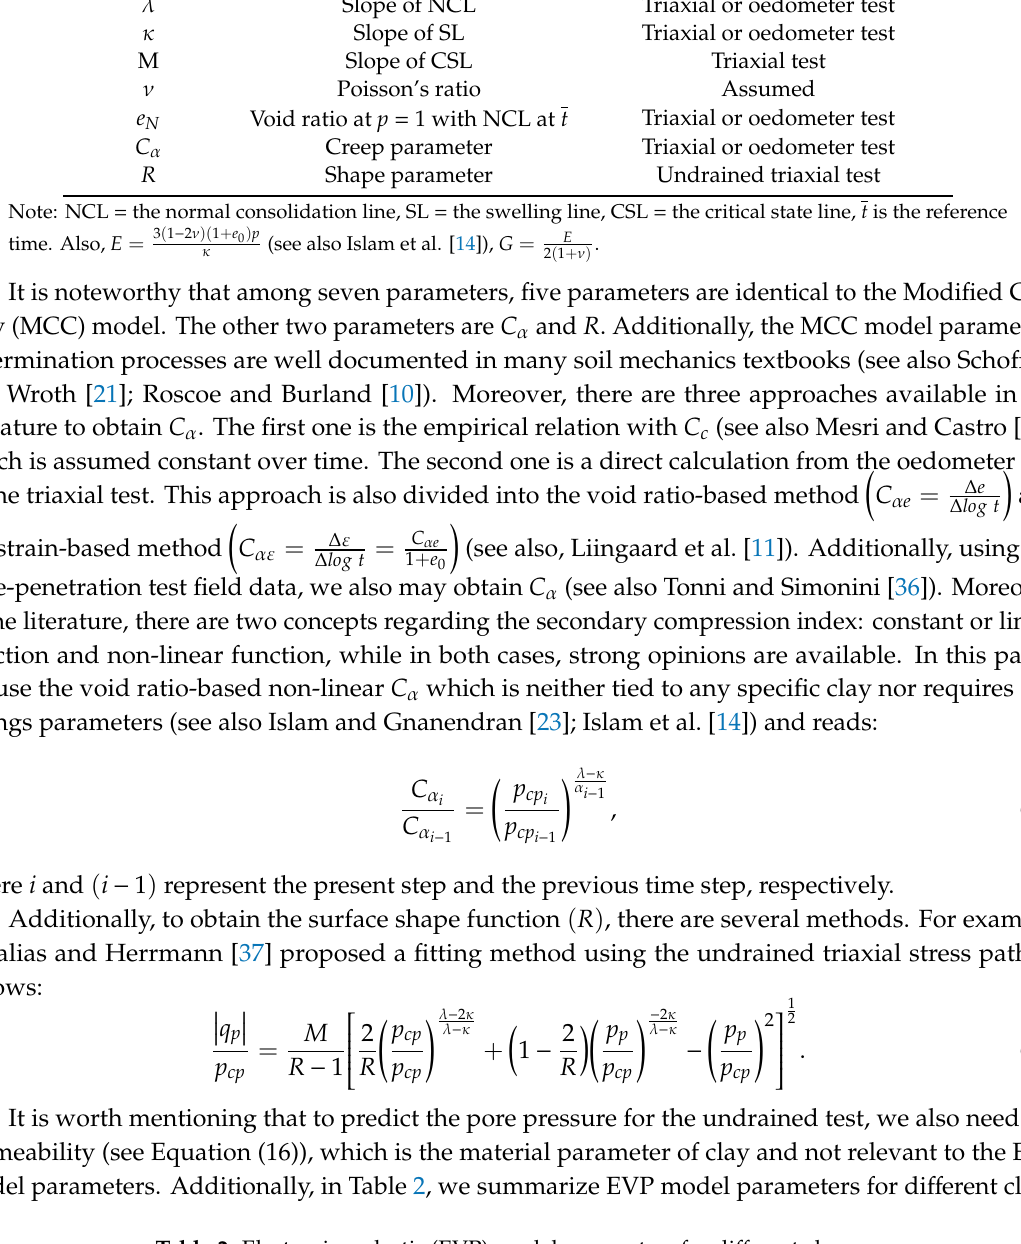
Table 1. Model parameters in the elasto-viscoplastic model. Parameters Meaning Method of Determination λ Slope of NCL Triaxial or oedometer test κ Slope of SL Triaxial or oedometer test M Slope of CSL Triaxial test ν Poisson’s ratio Assumed e N Void ratio at p = 1 with NCL at t Triaxial or oedometer test C α Creep parameter Triaxial or oedometer test R Shape parameter Undrained triaxial test